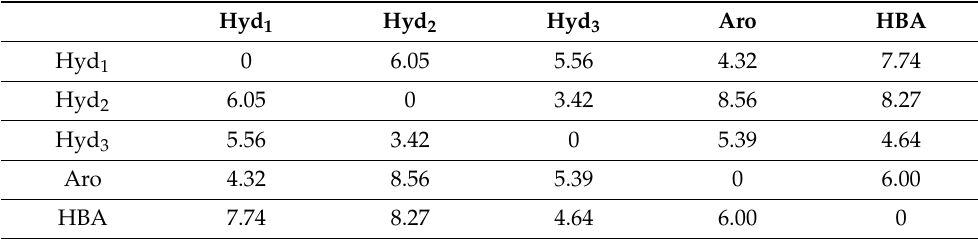
Table 1. Statistical parameters and mutual distances (Å) between features of pharmacophore model are